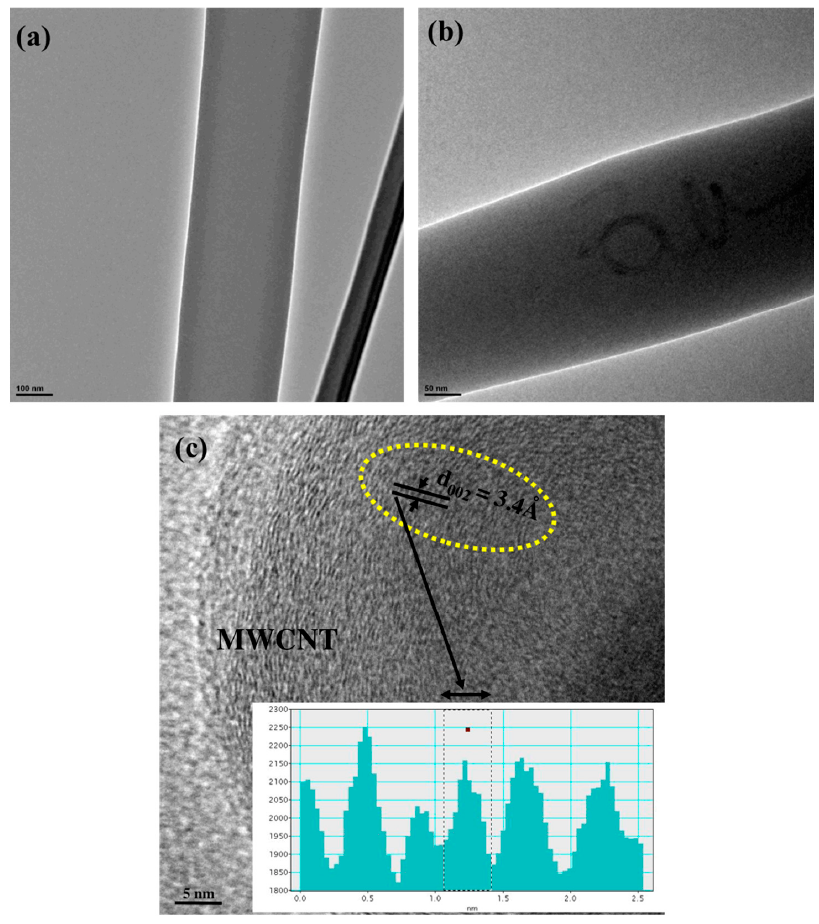
Figure 4. HRTEM analysis of: ( a ) SU-8 electrospun nanofiber; ( b ) MWNCT-embedded electrospun SU-8 nanofiber; ( c ) An atomic-scale of a MWCNT depicting interlayer spacing of 0.34 nm.